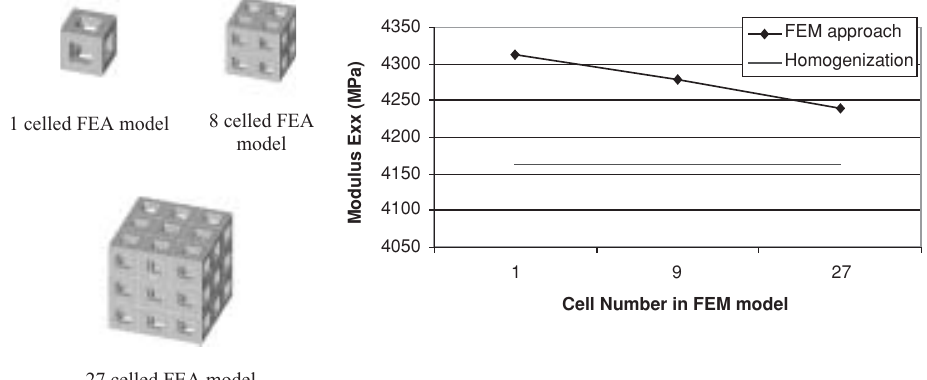
Figure 10 Effect of the number of base cells on the